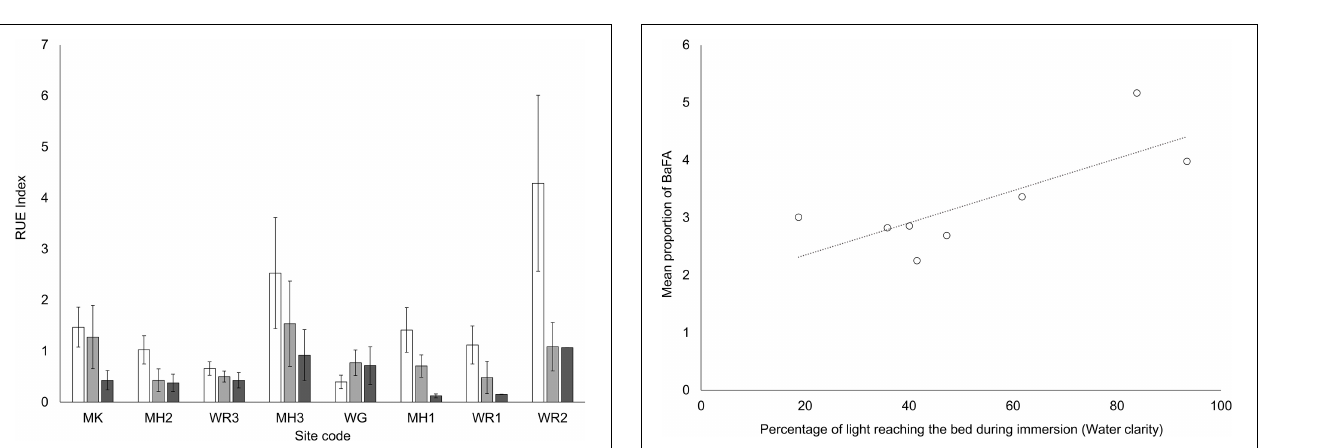
FIGURE 5 | Mean resource use efficiency (RUE), i.e., the ratio between chlorophyll a concentration and the sediment porewater concentration of the limiting nutrient [N in these systems (RUE calculations based on Eriksson et al., 2017)]. Nutrient treatments; white bars – control plots (0 g N m - 2 addition), light gray – medium plots (150 g N m - 2 addition), dark gray – high plots (600 g N m - 2 addition).